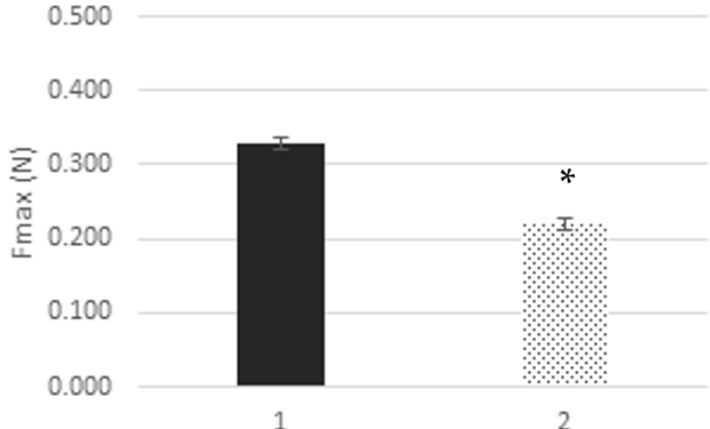
Figure 5. Texture analysis of the facial masks. ( 1 ) mask containing 5% of SSP; ( 2 ) control. Firmness (Fmax) is represented in the bars as mean ± standard deviation. *, Significant differences ( p < 0.05) were found between samples.